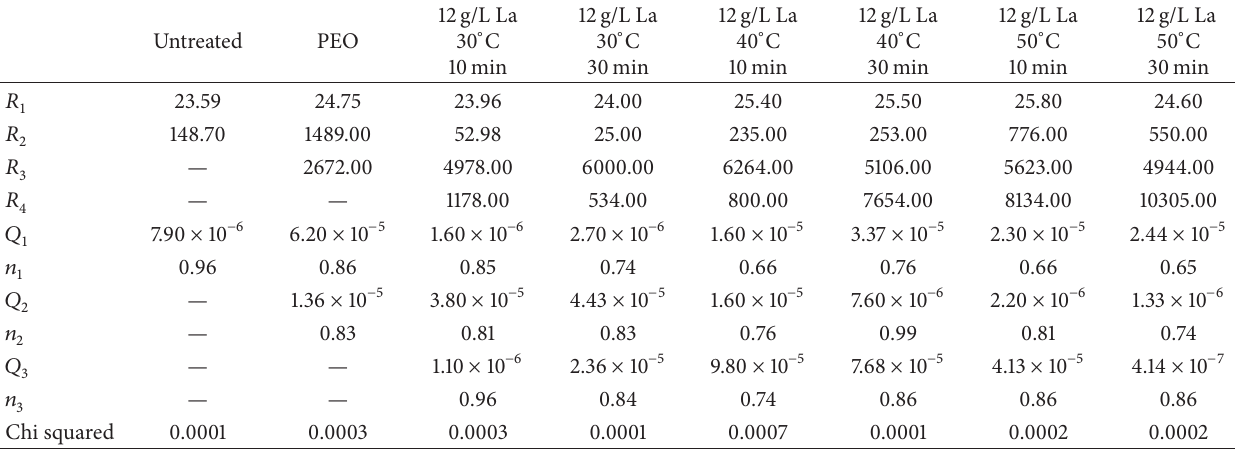
Table 3: Equivalent circuit data for samples sealed with 12g/l of La(NO 3 ) 3 at different temperature and for different treatment times, after PEO treatment.